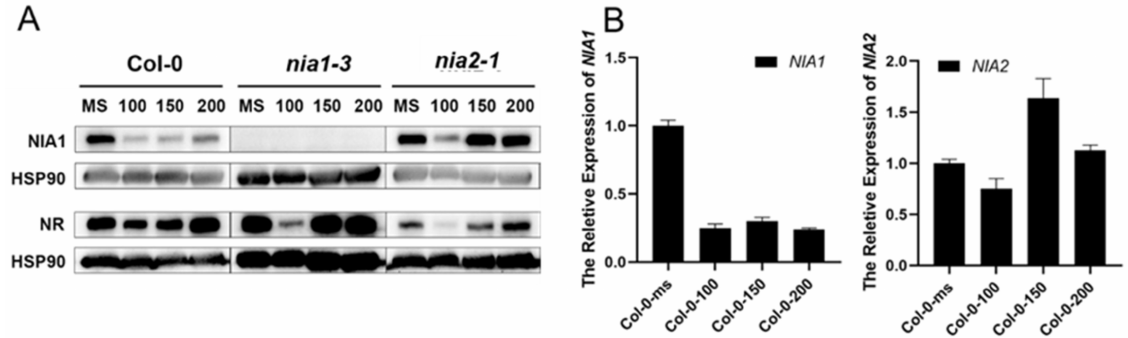
Figure 3. NaCl stress transcriptionally regulates the expression of NIA1 rather than NIA2. ( A ) Western blot of the proteins extracted from seedlings under the indicated treatments by the NIA1 antibody and NR antibody. The quantification of the relative levels of NIA1 or NR proteins are shown below; ( B ) gene expression analysis of NIA1 or NIA2 transcripts in Col-0 under indicated treatments. Three biological repeats.